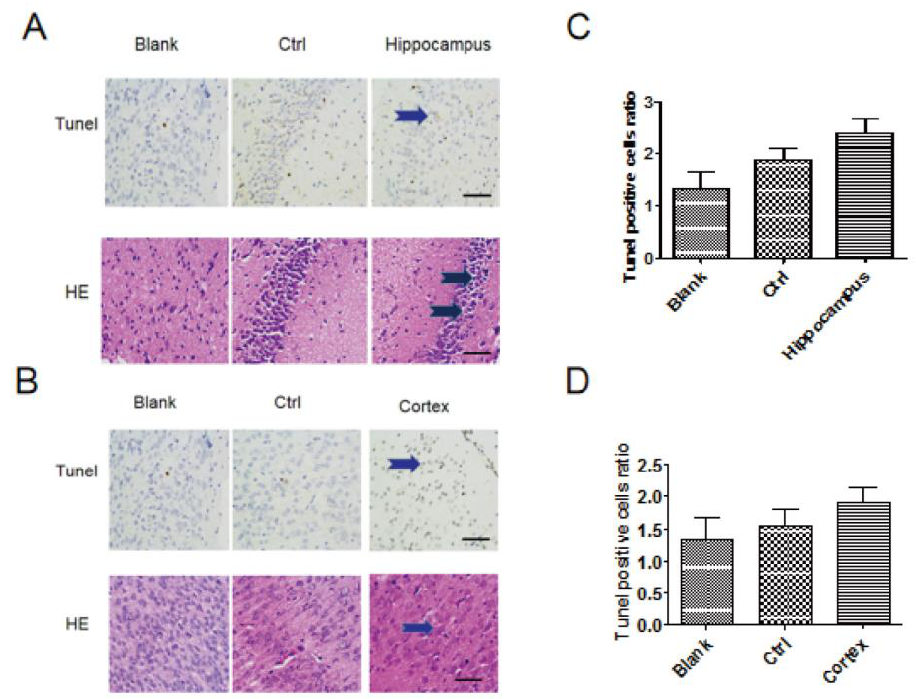
Figure 3. ( A , B ) Observation of the HE and TUNEL staining for the hippocampus and cerebral cortex tissue in morphological changes in each group ( × 400). ( C , D ) Scale bar = 200 µ m. The neural cell apoptosis statistical analysis was conducted using TUNEL and HE staining from each offspring rat’s hippocampi and cerebral cortex tissue. All data were derived from the TUNEL staining results of independent experiments. Values are the mean ± SD of triplicate experiments and are analysed using one-way analysis of variance (ANOVA) with Tukey post hoc tests. There was no significant change compared to the control group.